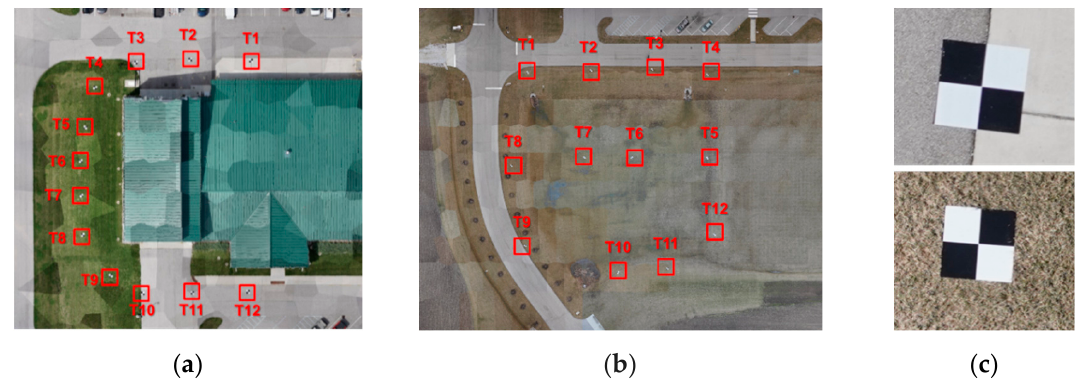
Figure 3. Study sites ( a ) I and ( b ) II with red boxes highlighting the deployed checkboard targets (denoted as T1-T12), as well as ( c ) sample images of the targets.